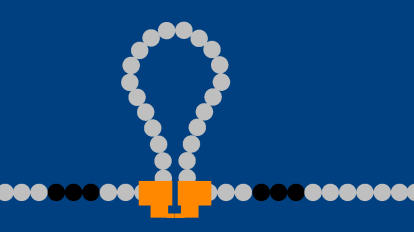
Two hnRNP proteins interact to connect the two ends of an intron, forming a loop to help the cell's splicing machinery remove the intron